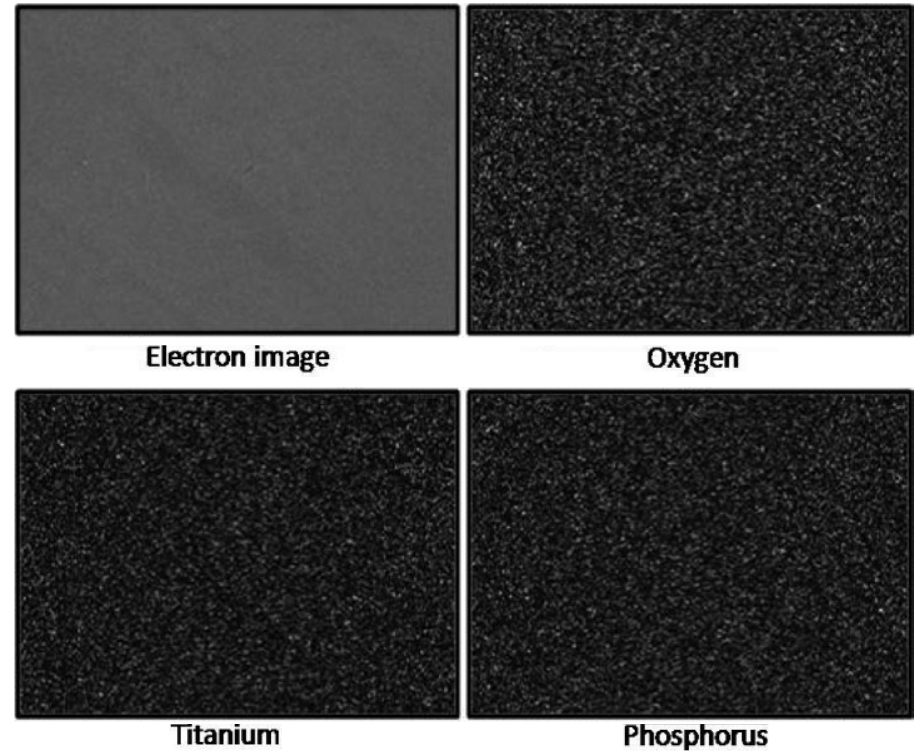
Figure 12. Distribution of the elements Ti, O and P in thin film doped with 15 mol% and annealed at 600